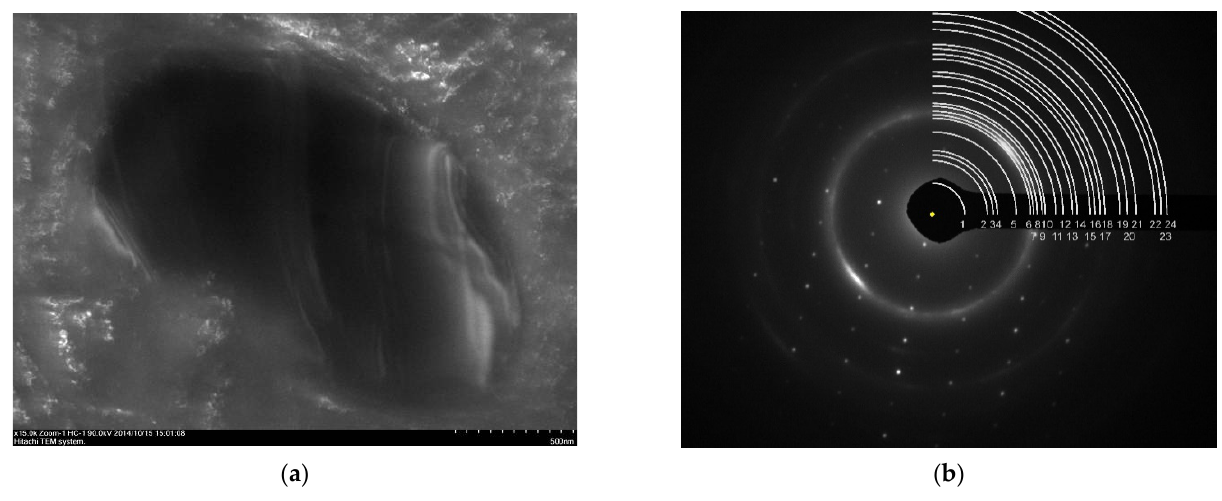
Figure 7. Electron microscopic image from the neck region of the stretched Ni 51 Ti 49 sample in the dark field mode ( a ) and electron diffraction from this region ( b ). Table 3. Results of decoding the diffraction pattern shown in Figure 7.